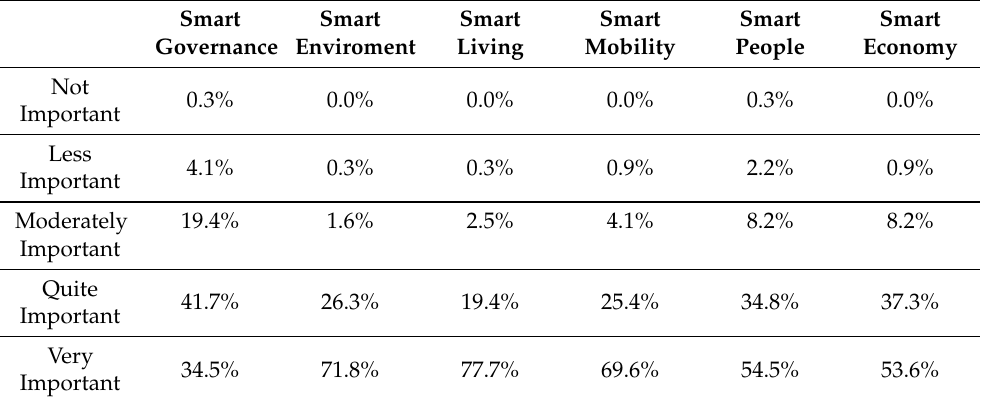
Table 2. Importance of smart city